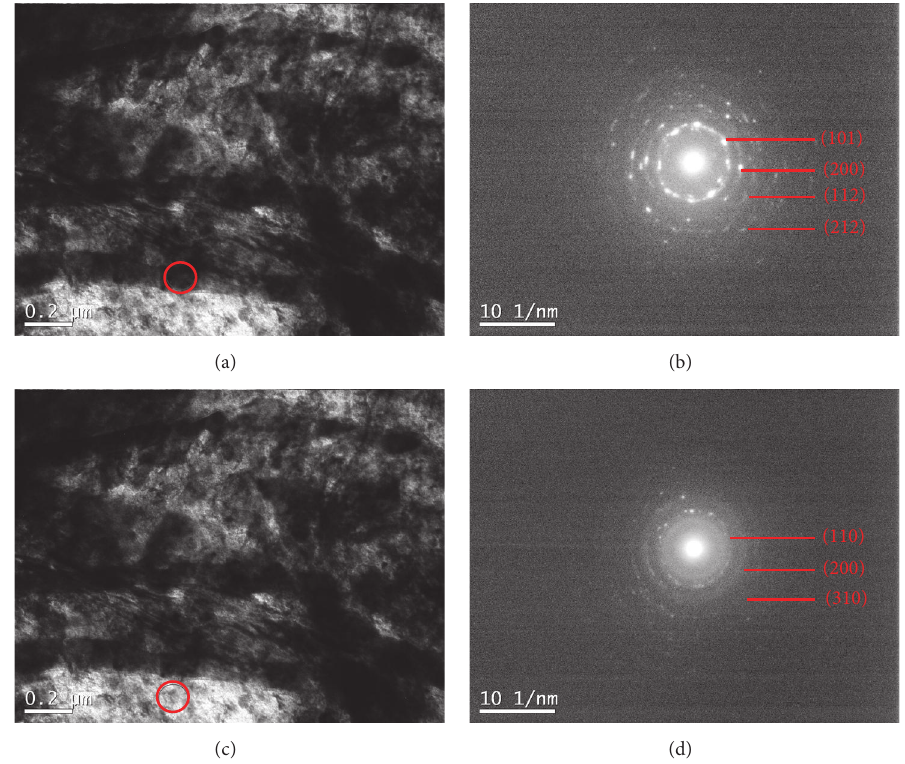
Figure 8: SAED image of the pearlite in 1045 carbon steel with annealing at 873 K (600 ∘ C) for 2